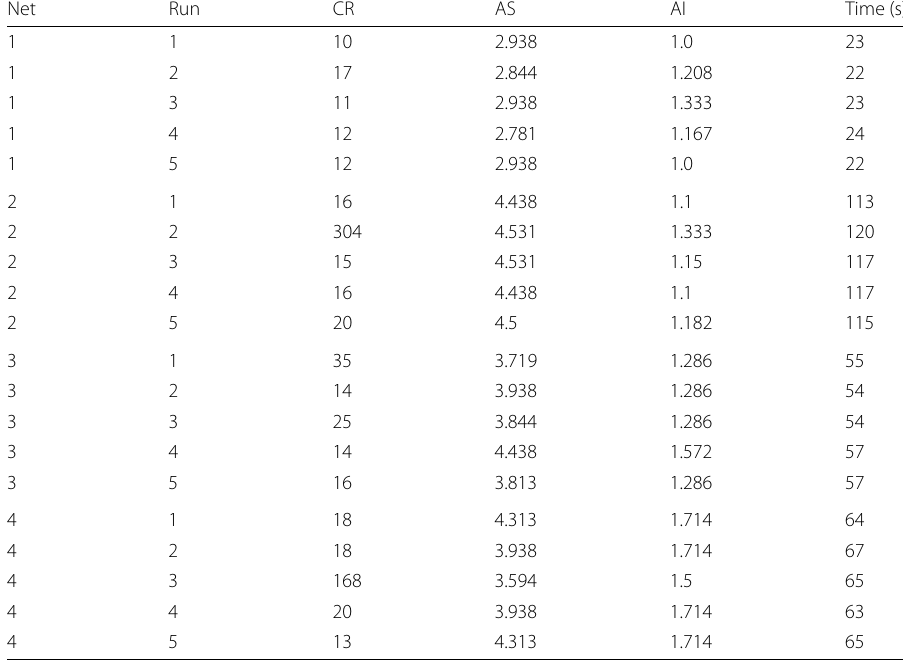
Table 3 Performance statistics for the four different network structures, with five runs per structure Net Run CR AS AI Time (s) 1 1 10 2.938 1.0